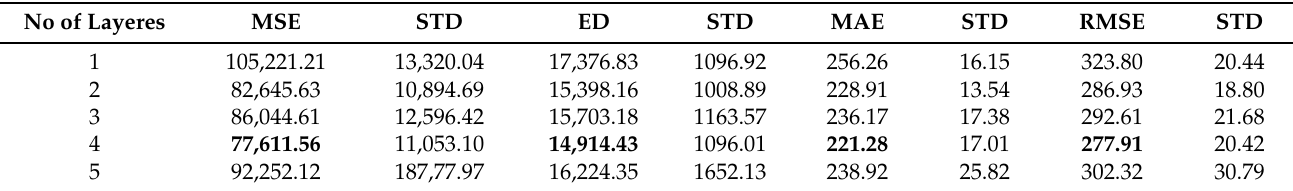
Table 1. Error forecasting results for hourly daily load consumption, using a different number of layers feed forward neural network.